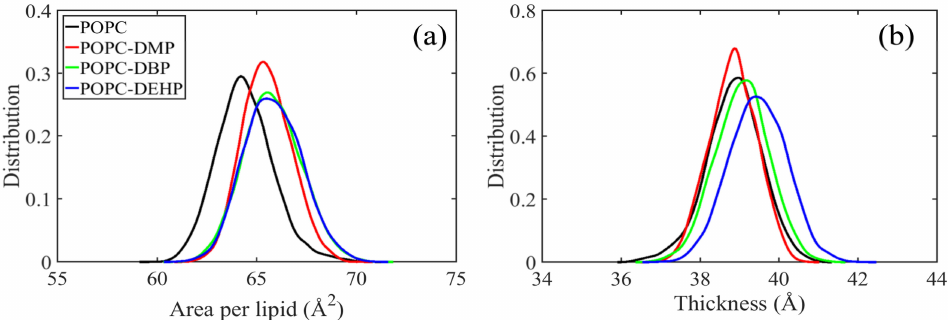
Figure 4. Effects of different PAEs permeation on membrane. ( a ) Area per lipid. ( b ) Bilayer